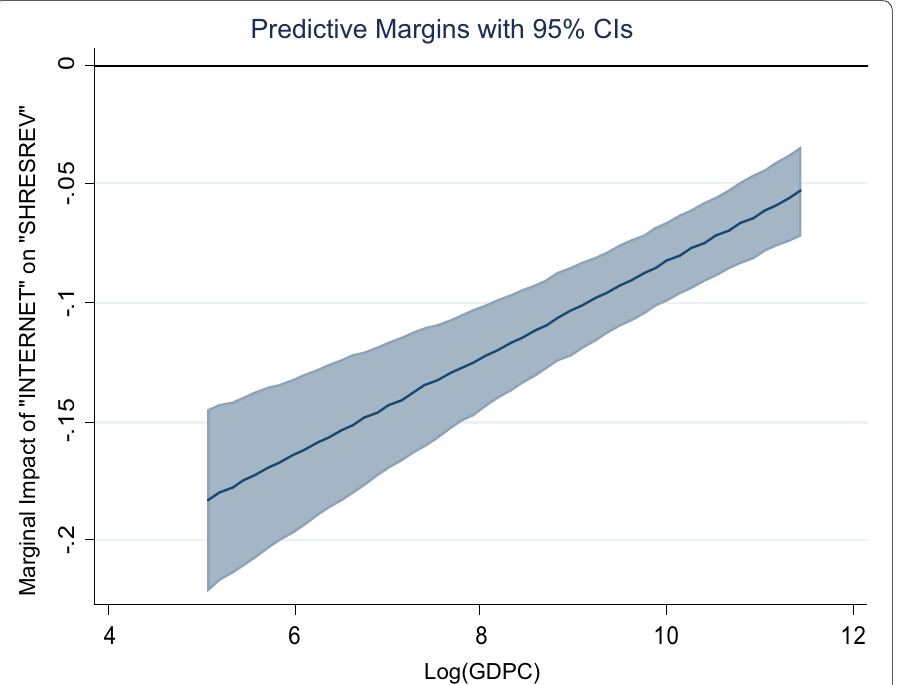
Fig. 4 Marginal impact of “INTERNET” on “SHRESREV”, for varying countries’ levels of development. Source :